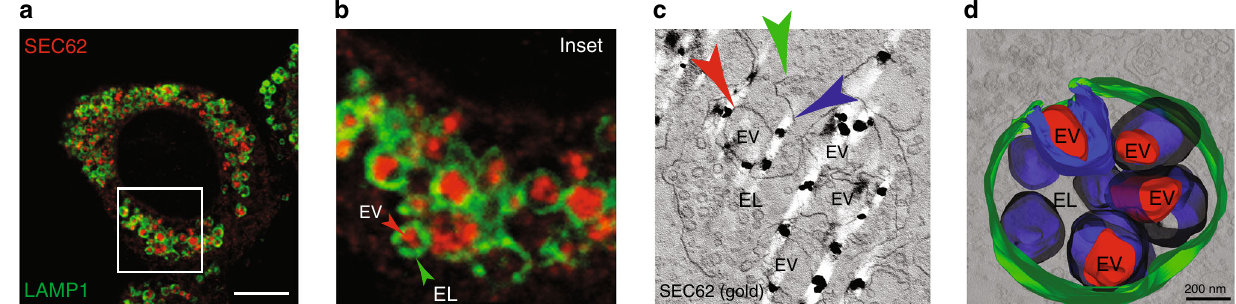
Fig. 4 Engulfment of endogenous SEC62-labeled EV by EL. a WT MEF after 12 h recovery from an ER stress in the presence of 50 nM BafA1. IF panel is representative of >10 independent experiments. b Inset from a . c Single slice of an electron tomogram showing the distribution of gold-labeled endogenous SEC62 during recovery from ER stress. IEM image is representative of two independent experiments with similar results. Color code of arrows in b , c as in Fig. 2a – d . d 3D visualization by electron tomography of EL containing EV that display gold-labeled, endogenous SEC62 at the limiting membrane. See also Supplementary Movie 1. Scale bar for CLSM: 10 μ m; scale bar for IEM: 200